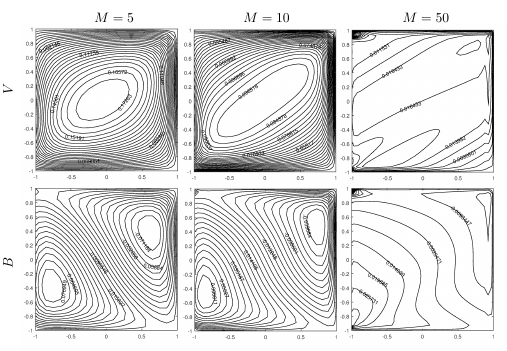
Figure 9. Velocity and induced magnetic field from direct problem, π , α = 0 . 2 , c = 0 . 3. β = 3